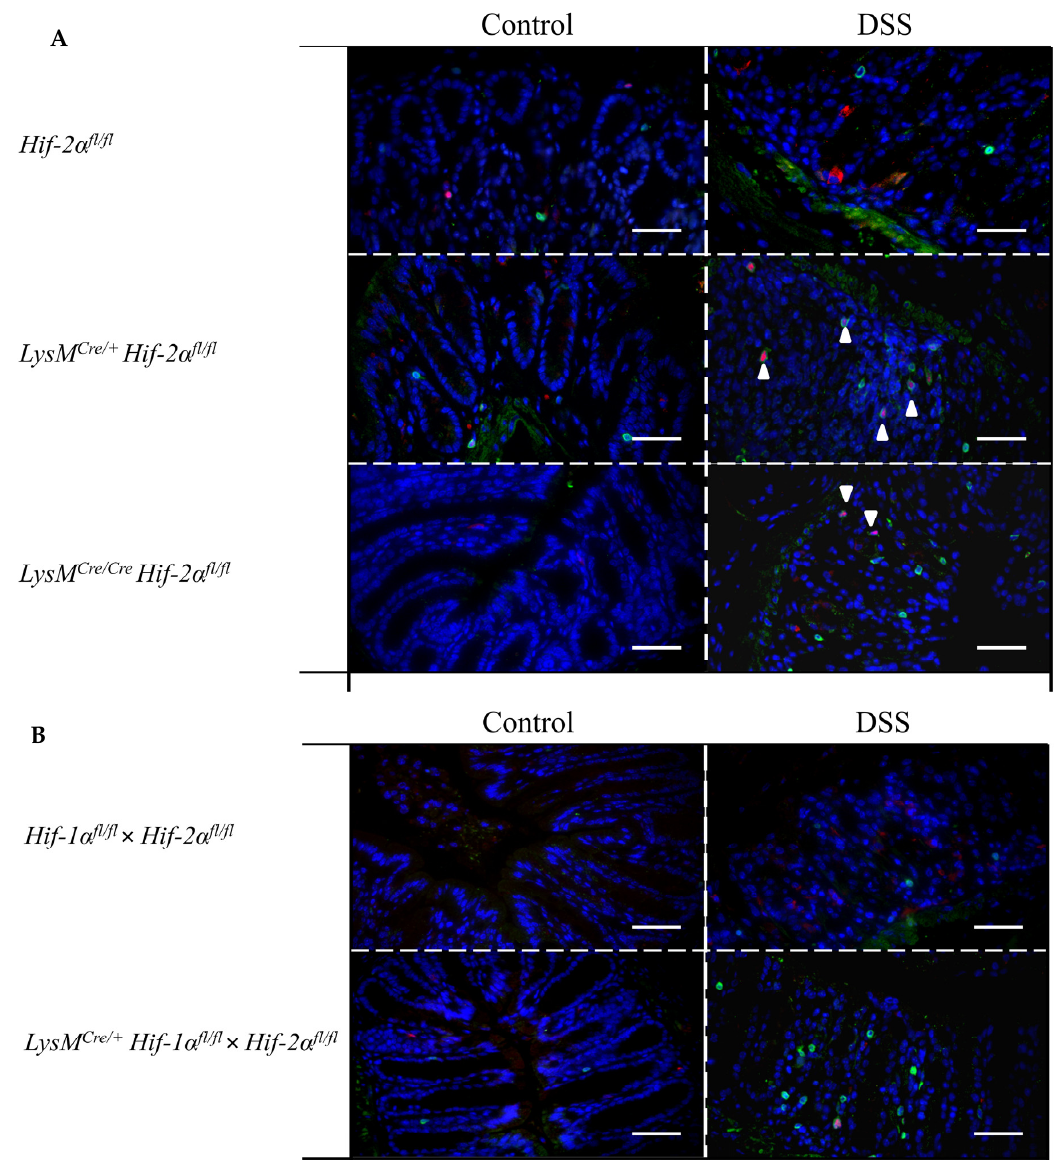
Figure 8. Myeloid knockout of HIF-2 α increased the numbers of T-cells and Treg cells in inflamed colon tissue. Exemplary presentation of CD3- (green, surface staining) and FoxP3- (red, nuclear staining) stained colon tissue sections of ( A ) Hif-2 α fl / fl , LysM Cre /+ Hif-2 α fl / fl and LysM Cre / Cre Hif-2 α fl / fl animals, and ( B ) Hif-1 α fl / fl × Hif-2 α fl / fl and LysM Cre /+ Hif-1 α fl / fl × Hif-2 α fl / fl animals with and without DSS treatment. ( A , B ): n (Control) = 2; n (DSS) = 4 (magnification 200 × , scale bar: 100 µ m). Marked cells (arrows) are double-positive for CD3 and